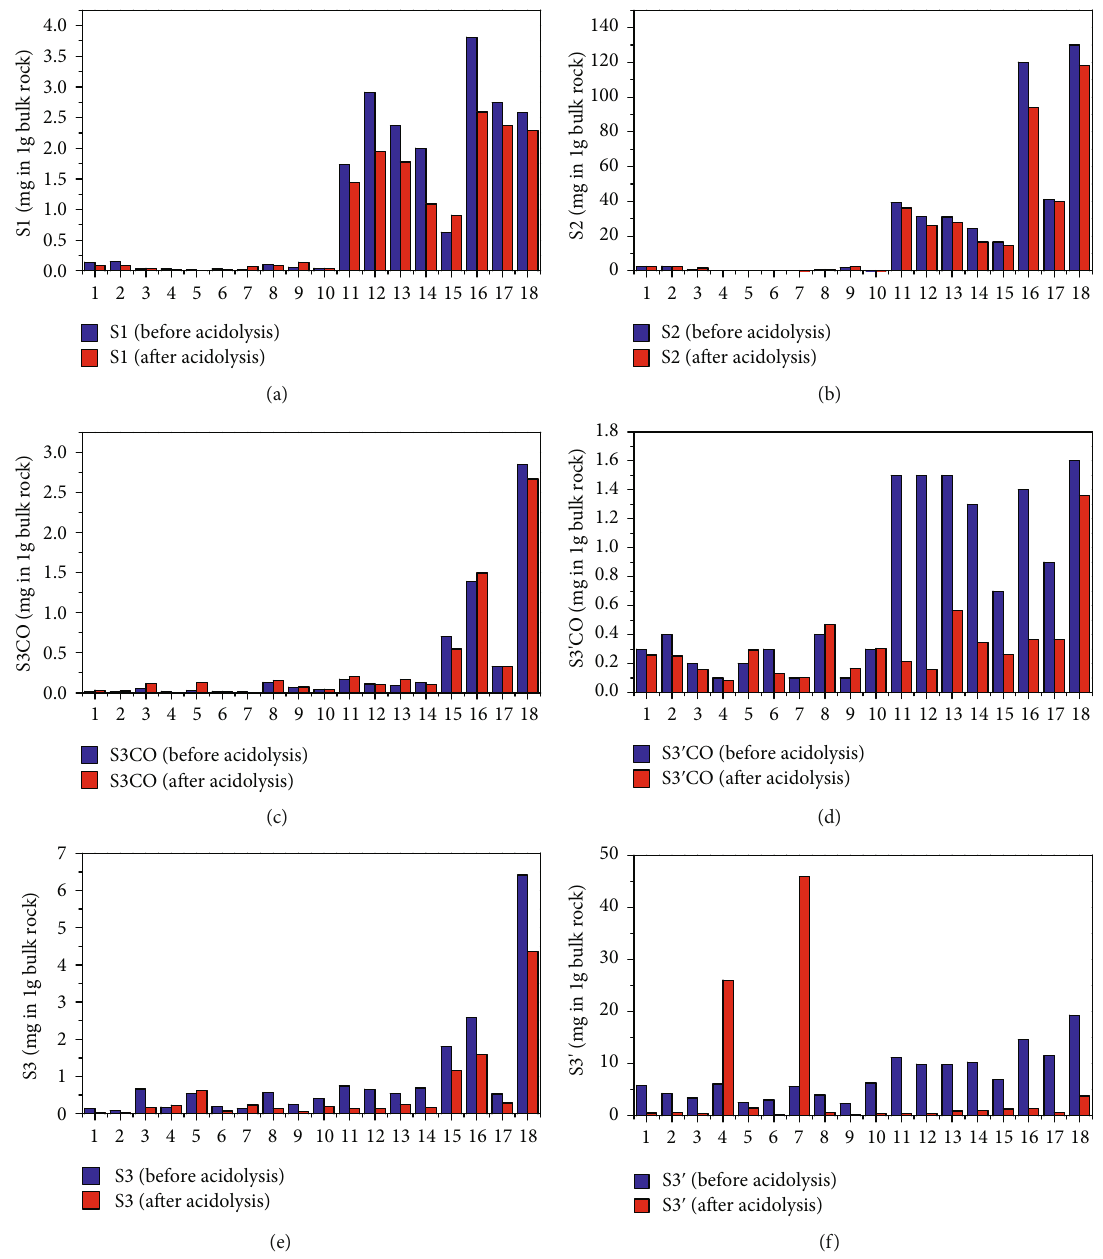
Figure 1: Comparison of bulk rock normalized S1 (a), S2 (b), S3CO (c), S3 ′ CO (d), S3 (e), and S3 ′ (f) for initial rock before and after acidolysis. Numbers 1-10 represent the high maturity samples YDGZ-08, YDGZ-09, QT-16, CJG-27, WHSX-17, CJG-40, CJG-17, LMD- 15, QT-14, and WHSX-09, respectively. Numbers 11-18 represent the low maturity samples Eagle Ford-01, 03, 06, 08, 09, Greenriver Fm, Mid Woodford, and YJG,